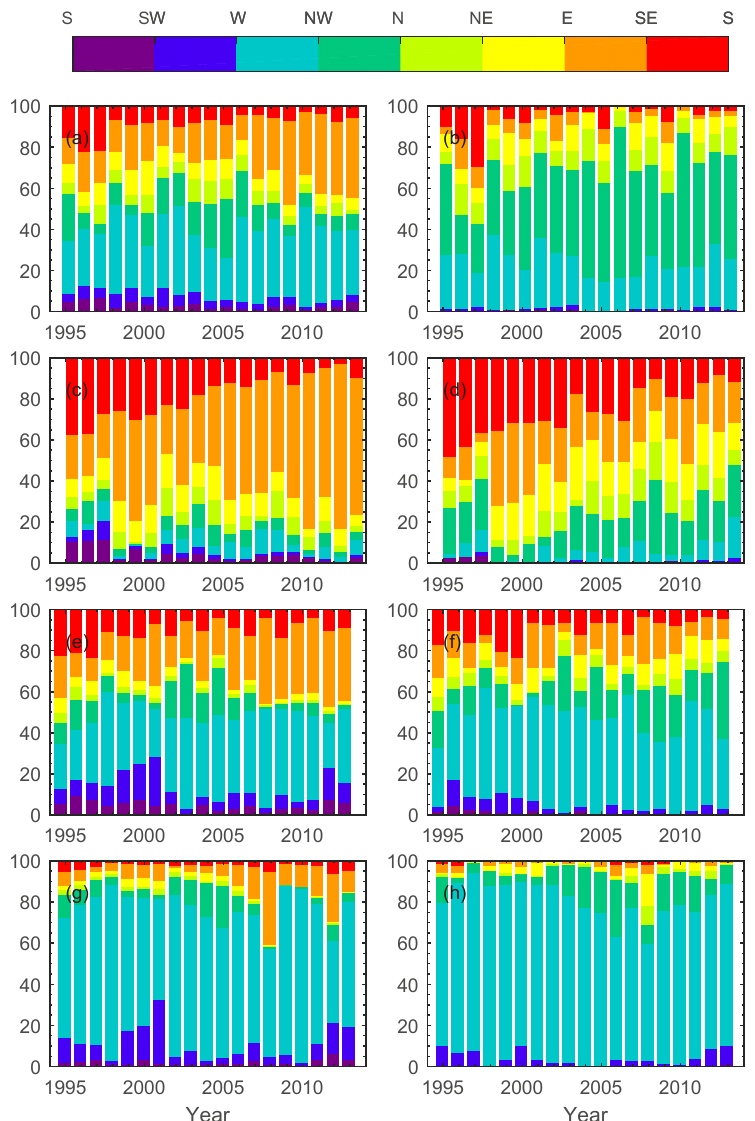
Figure 2. The average trajectory direction occurrence frequencies in (a, b) spring, (c, d) summer, (e, f) autumn, and (g, h) winter of (a, c, e, g) t < 24h and (b, d, f, h) t <